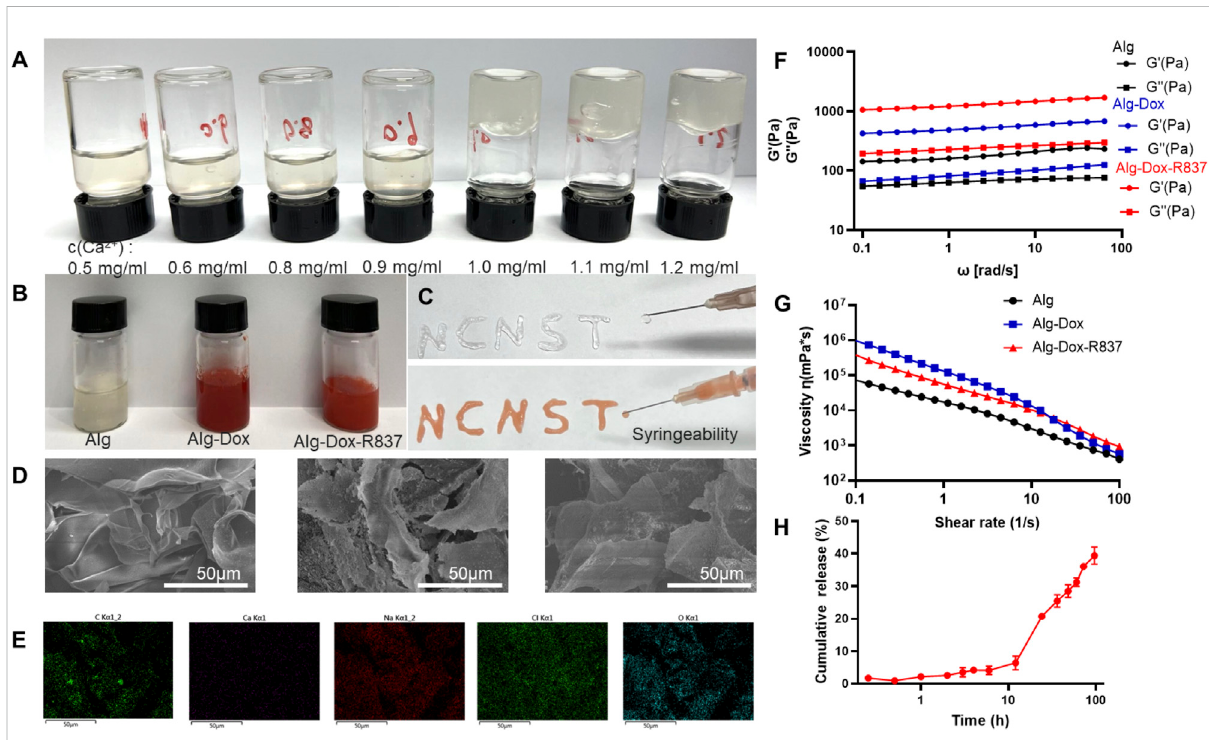
FIGURE 1 CharacterizationofAlg-Dox-R837hydrogel (A) GelformationwithdifferentCa 2+ concentrations; (B) Gelimageswithdifferentcomponents; (C) Alg-Dox-R837 formed “ NCNST ” ; (D) Morphological characterization of hydrogel with different compositions (scale bar: 50 μ m); (E) Elemental energyspectrumdistributionofAlg-Dox-R837; (F) LossmodulusandstoragemodulusofAlg,Alg-DoxandAlg-Dox-R837; (G) Viscosity versus shear rate for Alg, Alg-Dox and Alg-Dox-R837; (H) In vitro sustained release pro fi le of Dox in Alg-Dox-R837